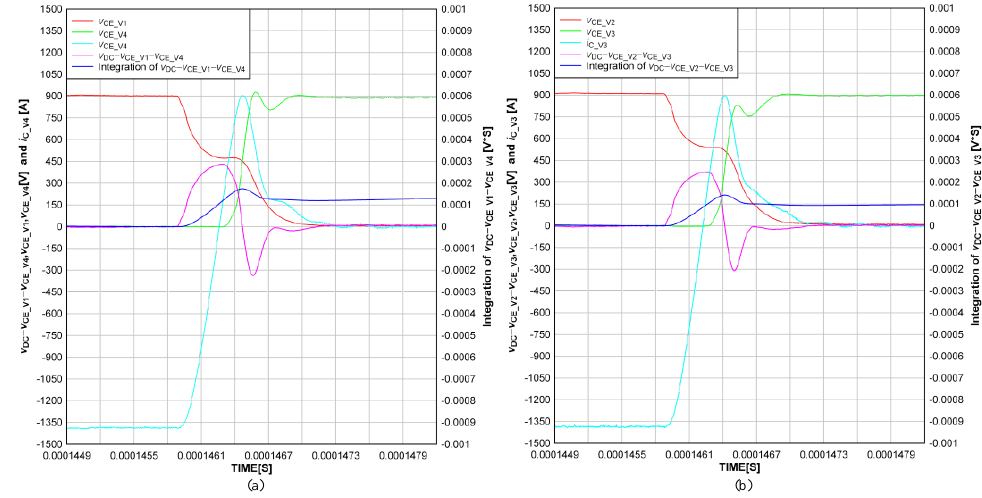
Figure 23. Stray inductance measurements of the PEBB of FC-3L-BDC. ( a ) The measurement of the outer commutation path. ( b ) The measurement of the inner commutation path.